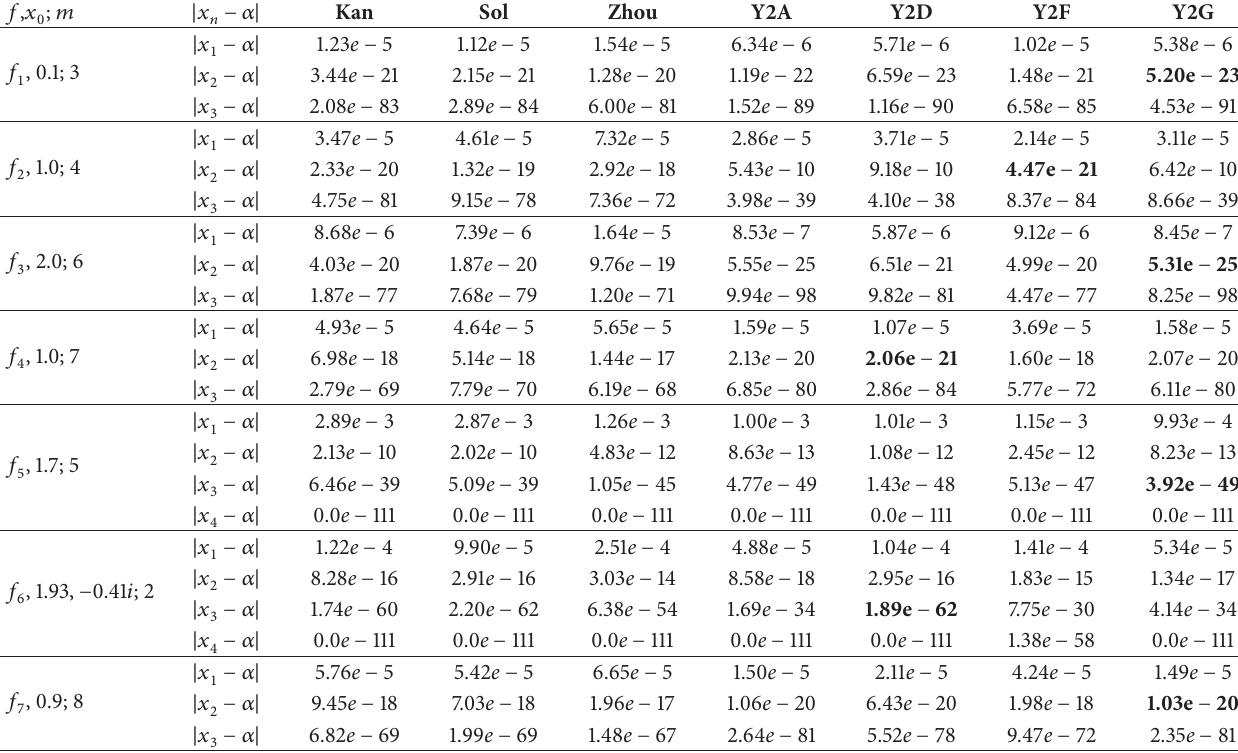
Table 9: Comparison of |𝑥 𝑛 − 𝛼| among existing and proposed (Case 2) multiple-root finders.